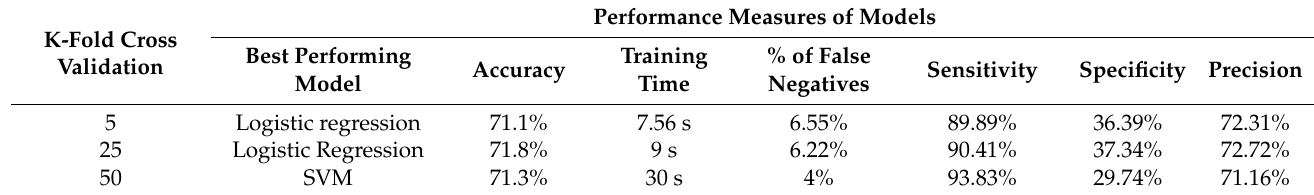
Table 1. Results obtained using k-fold cross validation.